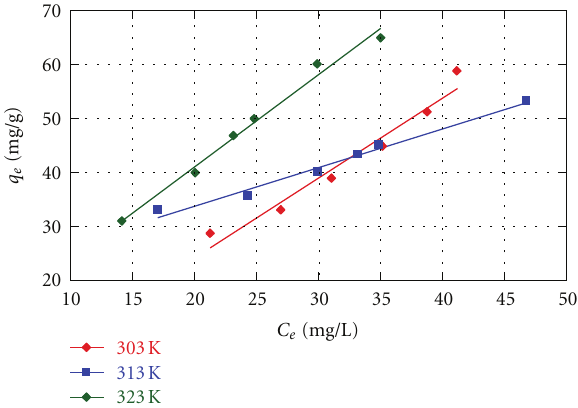
F 7: Adsorption isotherm plot of at 303K, 313K and